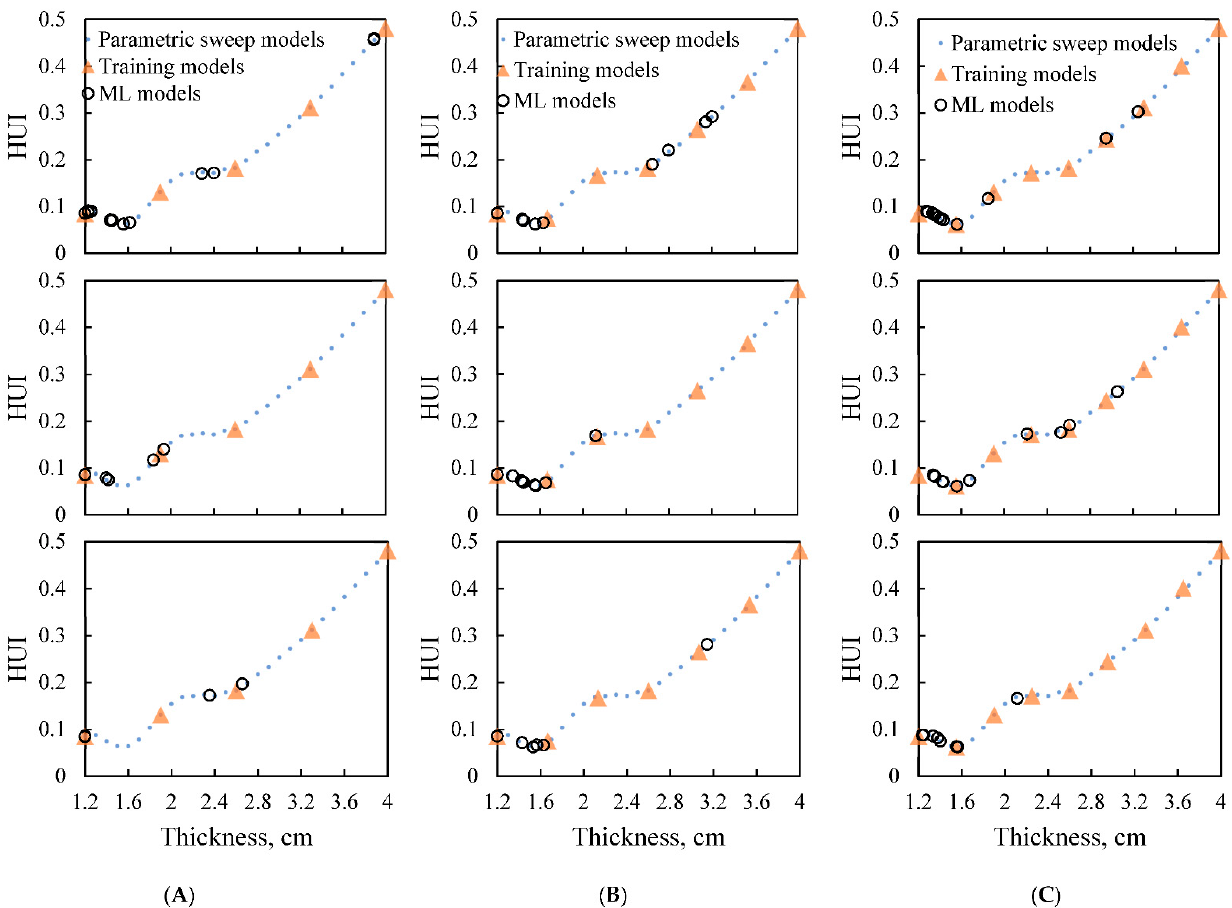
Figure 8. Machine-learning (ML) optimization process with evenly distributed initial training dataset consists of ( A ) five, ( B ) seven and ( C ) nine points for the rectangular frustum.